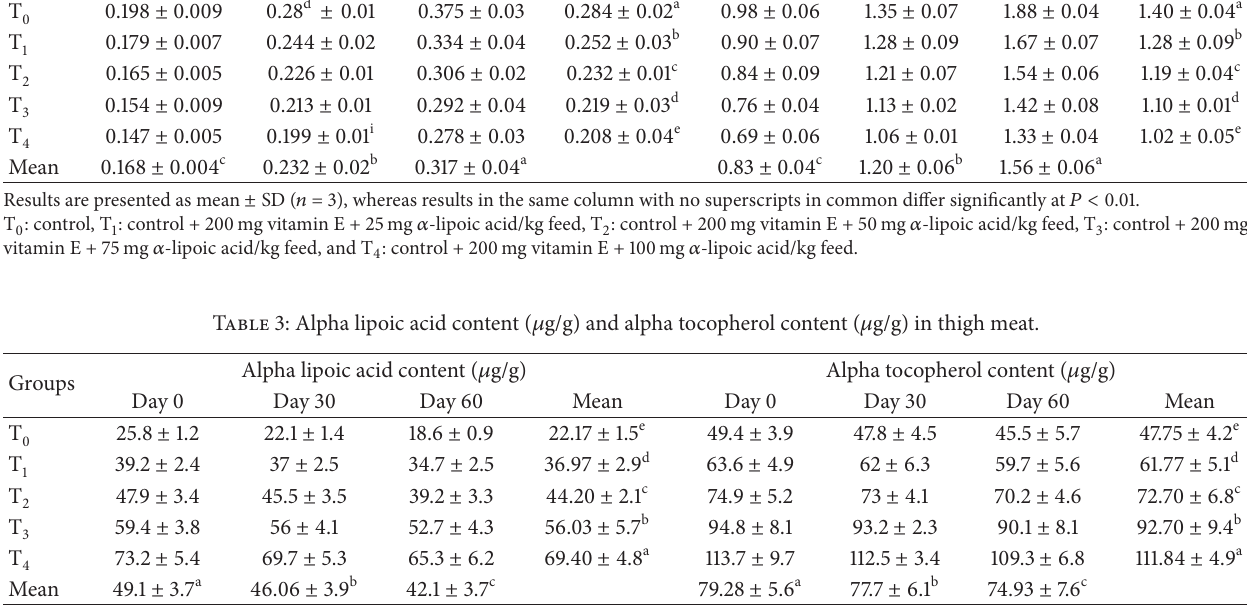
Table 2: Effect of different groups on TBARS value ( 𝜇 g MDA/g) and peroxide value (meq O TBARS value ( 𝜇 g MDA/g) Groups